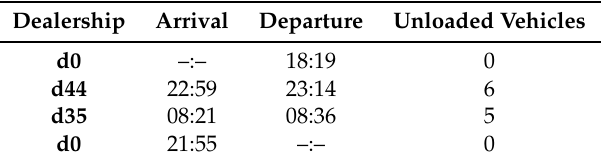
Table 10. Example of schedule of the auto-carrier